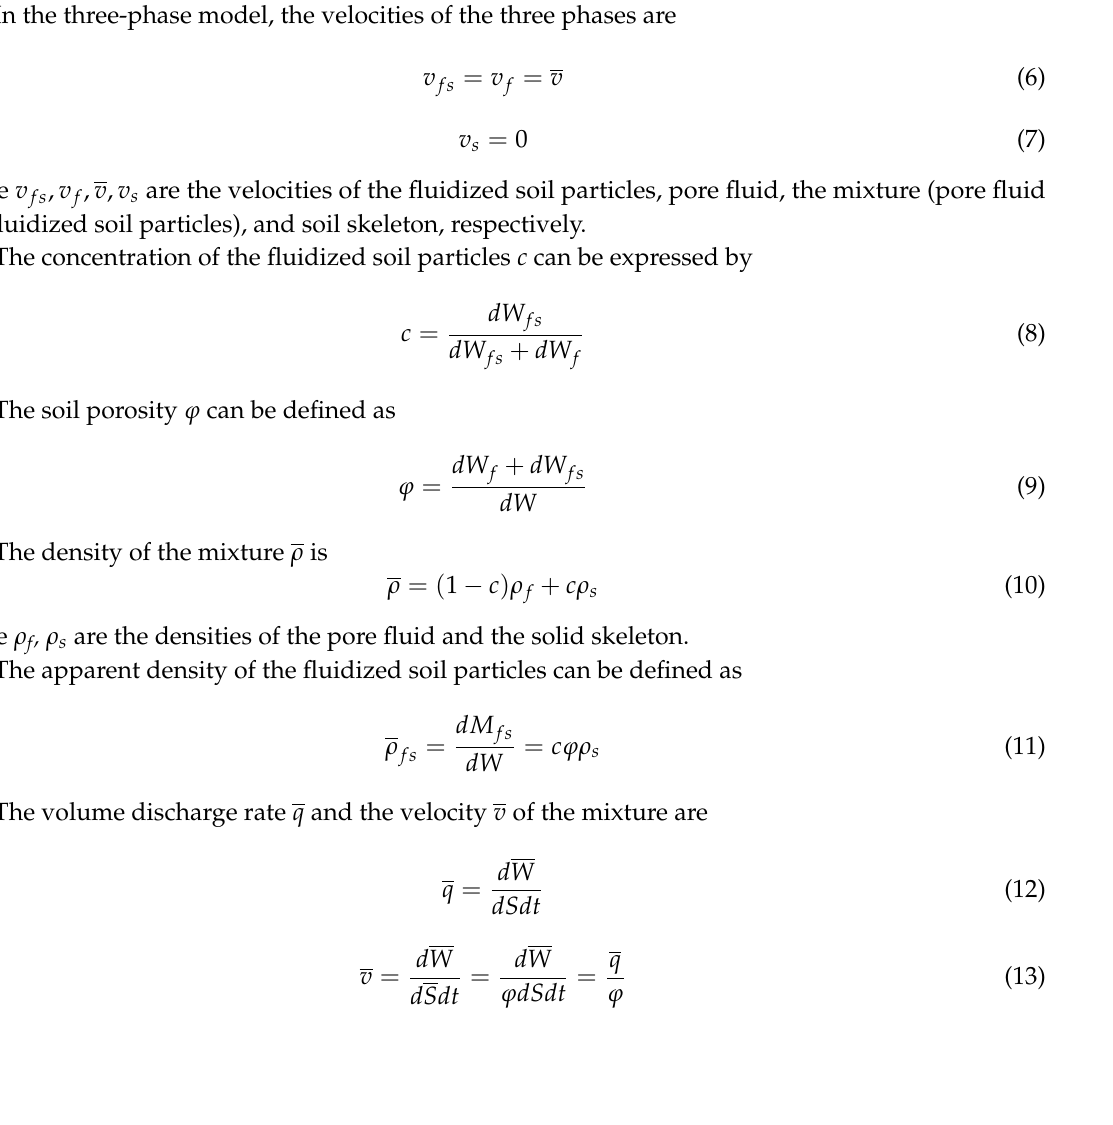
Figure 3. Three-phase theoretical model for the seabed